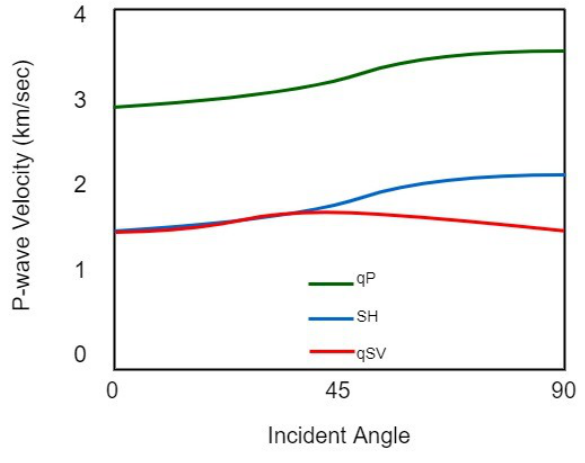
Figure 11. A plot of the velocity versus incident angle, obtained from ultrasonic measurements on shale cores.